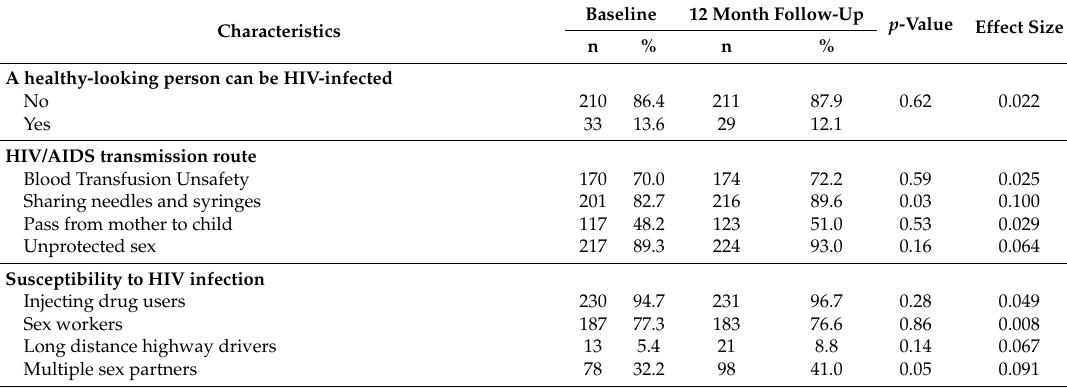
Table 1. Change in knowledge of HIV prevention and treatment among methadone maintenance treatment